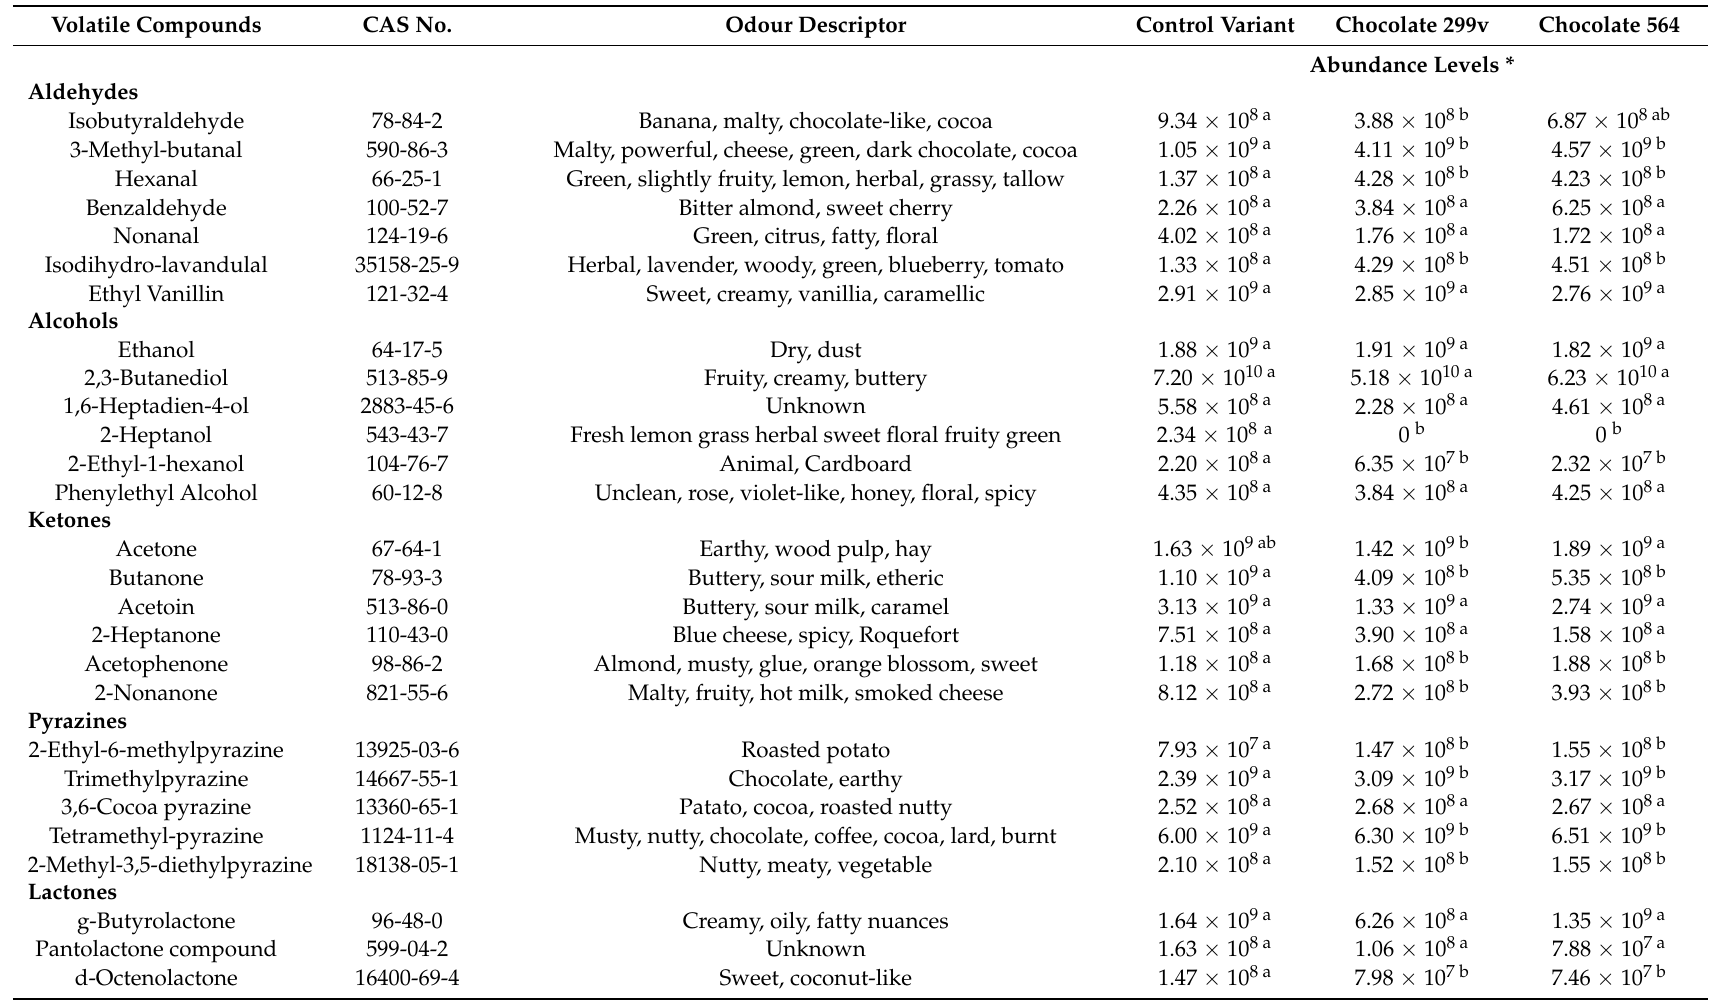
Table 3. Volatile compounds detected in dark chocolate with and without probiotic